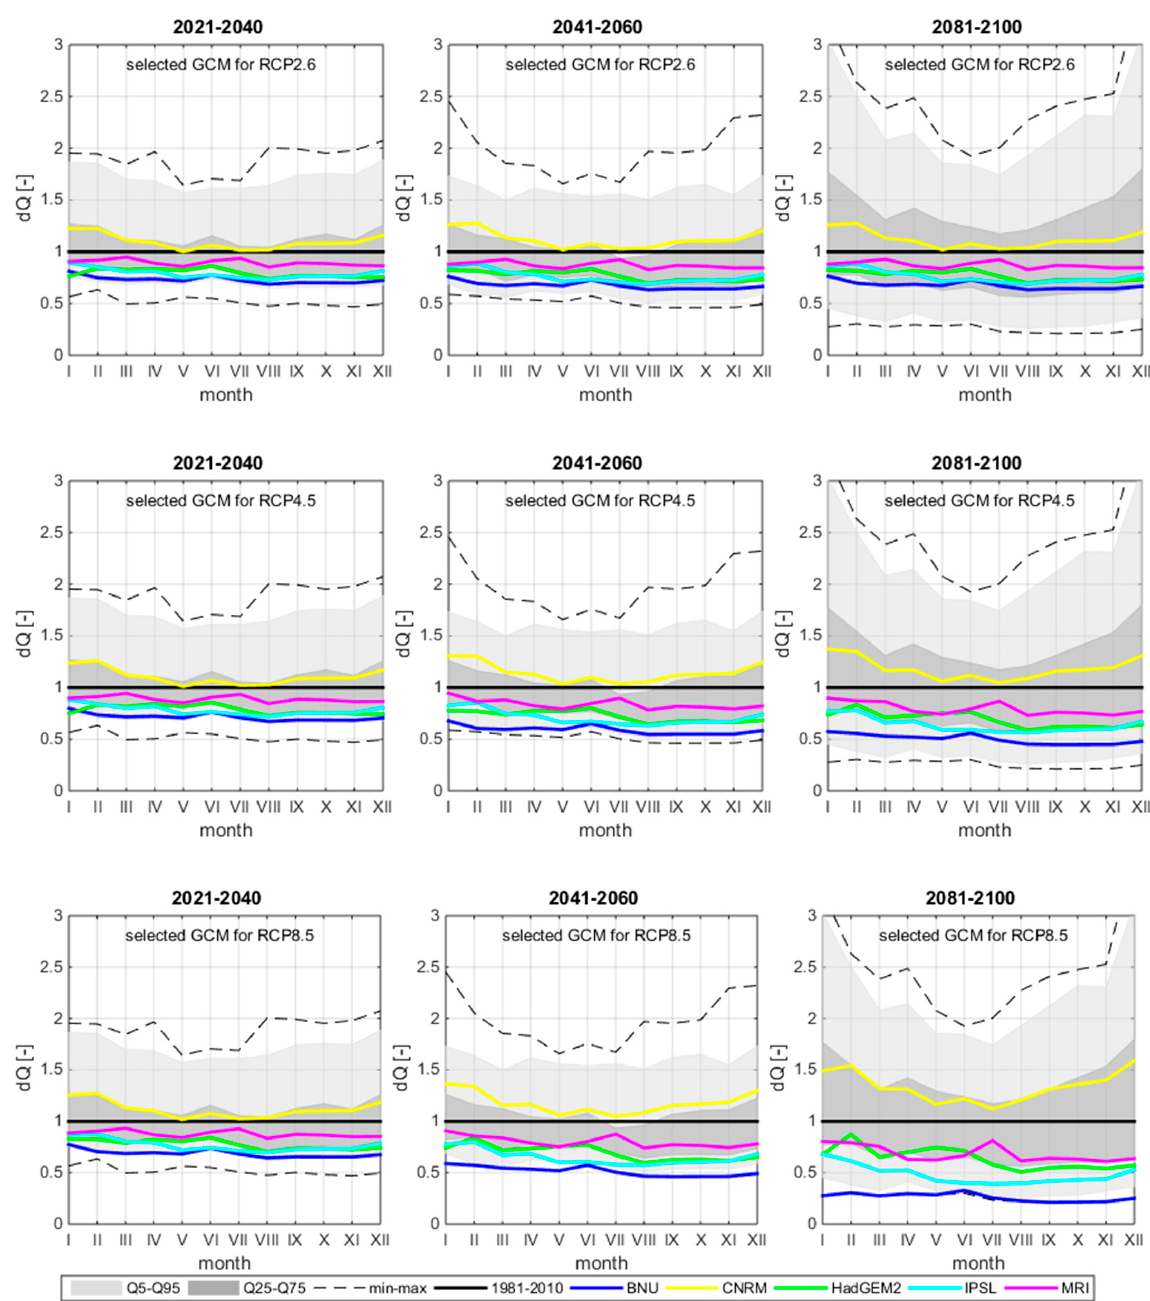
Figure 5. Uncertainty of the estimated basin outflows for individual time horizons (columns). The 90% (Q5–Q95) and 50% (Q25–Q75) confidence intervals are calculated for the ensemble of all 34 model outputs. The GCM models from the CMIP5 model for selected RCP emission scenarios (rows) are marked in color.